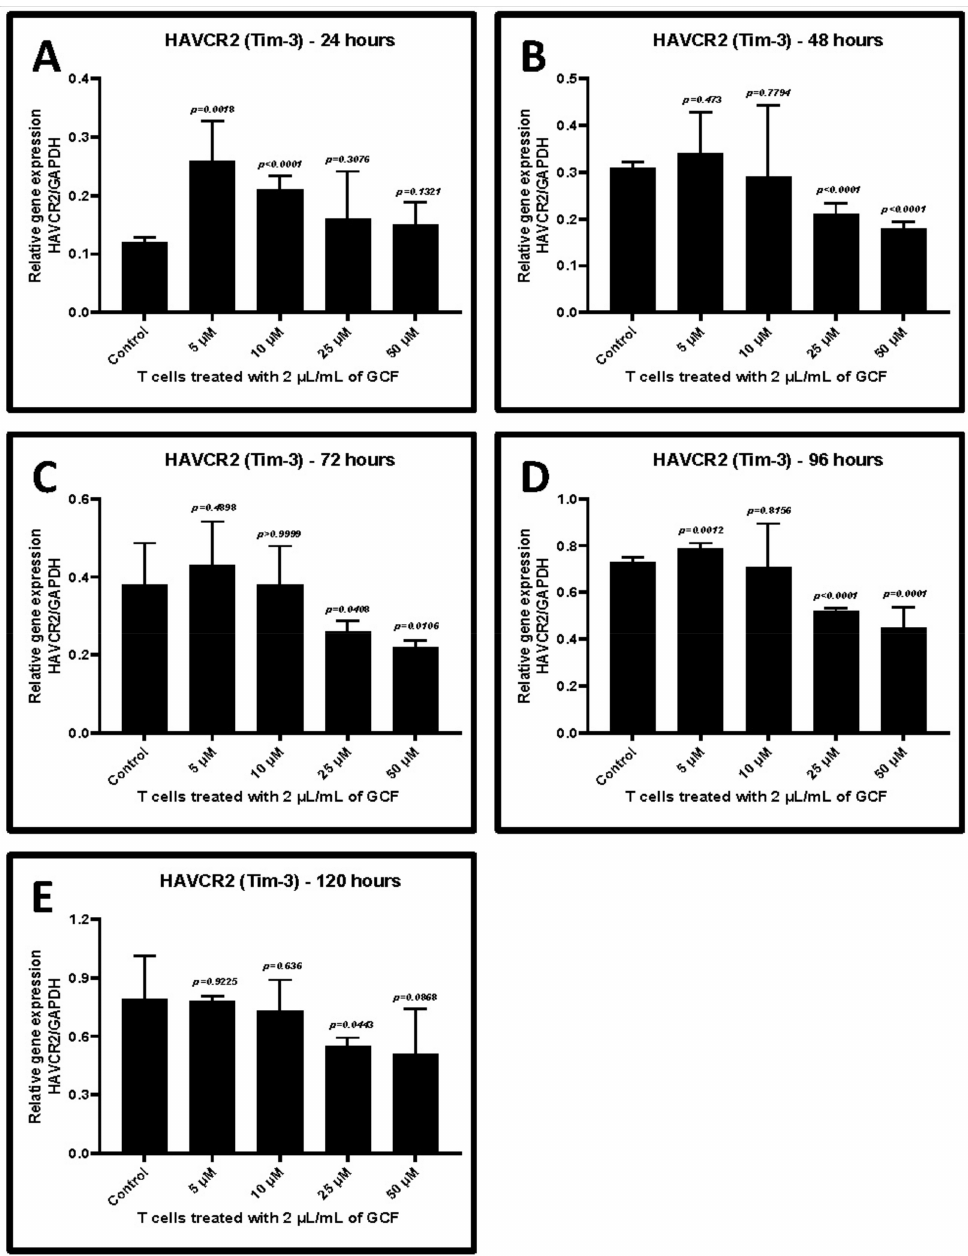
Figure 6. Relative gene expression of HAVCR2 (TIM-3) in 2 µ L/mL GCF-treated CD3+ T lympho- cytes treated with different concentrations of allicin (5, 10, 25, and 50 µ M). ( A ) Comparative gene expression of TIM-3 after 24 h of treatment. ( B ) Comparative gene expression of TIM-3 after 48 h of treatment. ( C ) Comparative gene expression of TIM-3 after 72 h of treatment. ( D ) Comparative gene expression of TIM-3 after 96 h of treatment. ( E ) Comparative gene expression of TIM-3 after 120 h of treatment. HAVCR2 (TIM-3) : T-cell immunoglobulin and mucin-domain containing-3, GCF: gingival crevicular